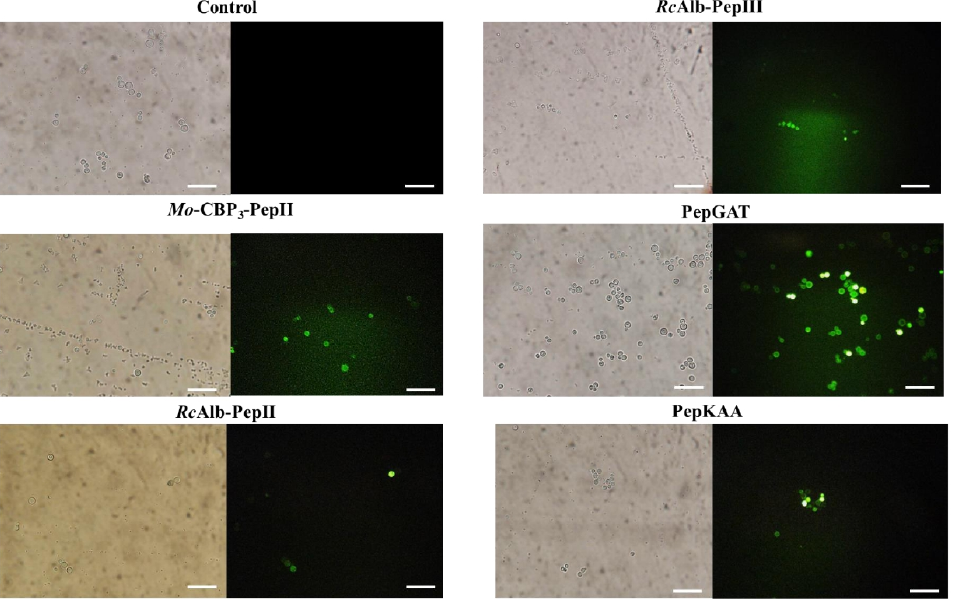
Figure 3. Fluorescence images showing membrane pore formation using fluorescein isothiocyanate (FITC)-dextran (6 kDa) induced by Mo -CBP 3 -PepII, Rc Alb-PepII, Rc Alb-PepIII, PepGAT, and PepKAA, respectively, at 25, 0.04, 0.04, 0.04, and 0.04 µg mL − 1 . C. neoformans cells were incubated with peptides and DMSO-NaCl. Detection of green fluorescence indicates that cells internalized FITC-dextran. Bars: 100 µm.